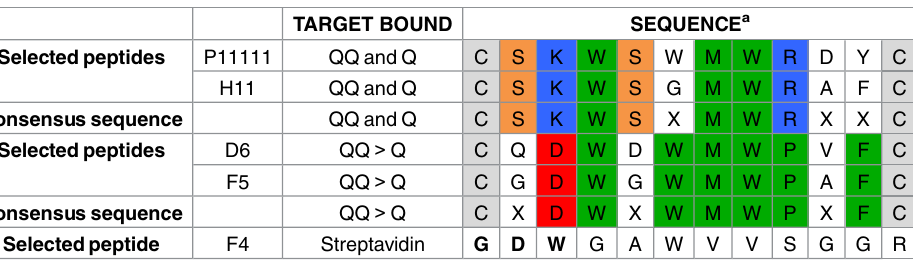
Table 3. Sequenceanalysisof selectedQBP or streptavidin-binding